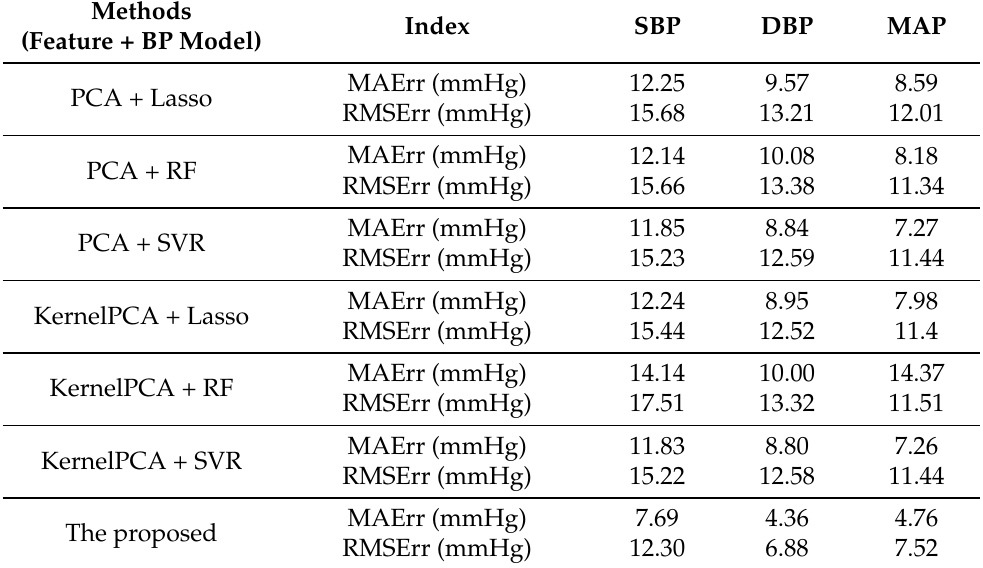
Table 4. Blood pressure (BP) Estimation Performance Comparison with Reference Machine Learn- ing